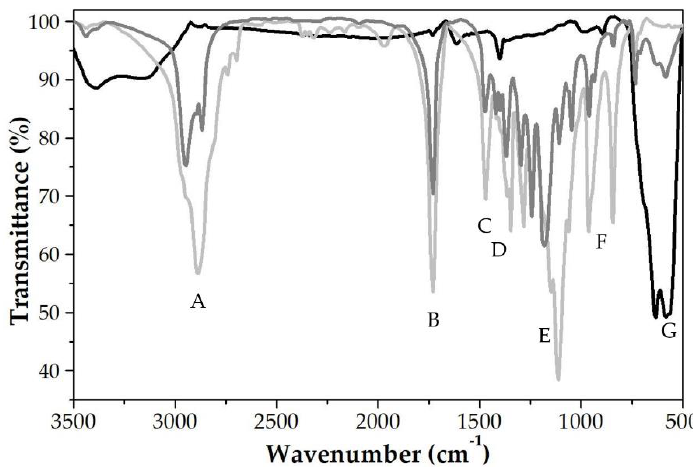
Figure 4. Infrared spectra of Fe 3 O 4 NPs (black line), PCL NPs (light grey line), and nanocomposites (dark grey line, of 2:4 Fe 3 O 4 :PCL weight ratio).